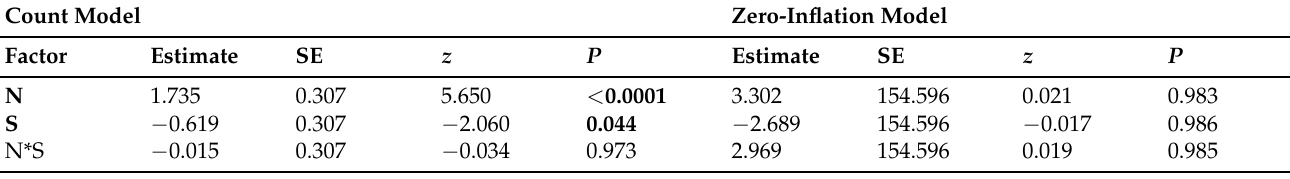
Table 2. Parameter estimates of the zero-inflated Poisson regression explaining EPT drift flux from first-order channels on day 22. The model includes two components: a count model (Poisson with log link), and a zero-inflation model (binomial with logit link). Significant effects ( P < 0.05) are indicated in bold.